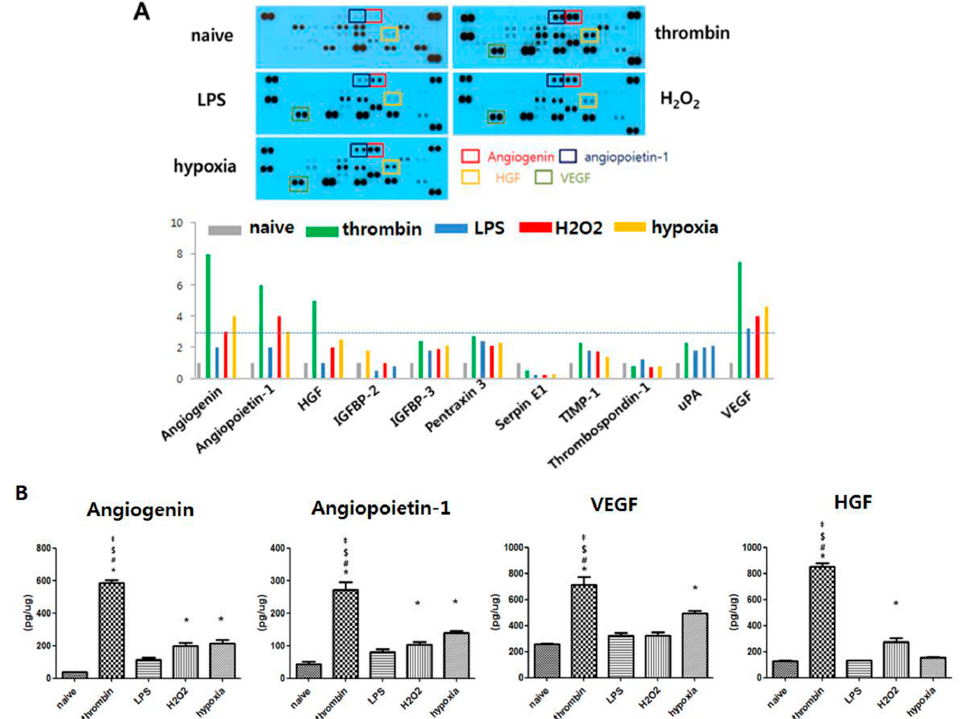
Figure 4. The EVs contain various cytokines and chemokines following stimulation with different wound mimetic environments. EVs were isolated from MSCs preconditioned with thrombin (40 U), LPS (1 µ g,) H 2 O 2 (50 µ M), or hypoxia (O 2 10%). ( A ) Representative screening X-ray film blot of Proteome Profiler Human Angiogenesis Array (PPHAA) for protein cargos of EVs (upper panel) and their representative diagram for the relative content of each protein expressed by fold change of blot intensity normalized with that of the naïve group. A gray dot line represents a three-fold increase over that of the naïve group. ( B ) Levels of angiogenin, angiopoietin-1, VEGF, and HGF measured by muliplex ELISA in EVs. Statistical analyses were carried out using a One-way Analysis of Variance (ANOVA). The asterisk (*) indicates p < 0.05 compared with naive EVs, the number sign (#) indicates p < 0.05 compared with the 10% oxygen-treated EV group, the double dagger ( ‡ ) indicates p < 0.05 compared to the H 2 O 2 -treated EV group, and the dollar sign ($) indicates p < 0.05 compared with the LPS-treated EV group ( n = 5 per each